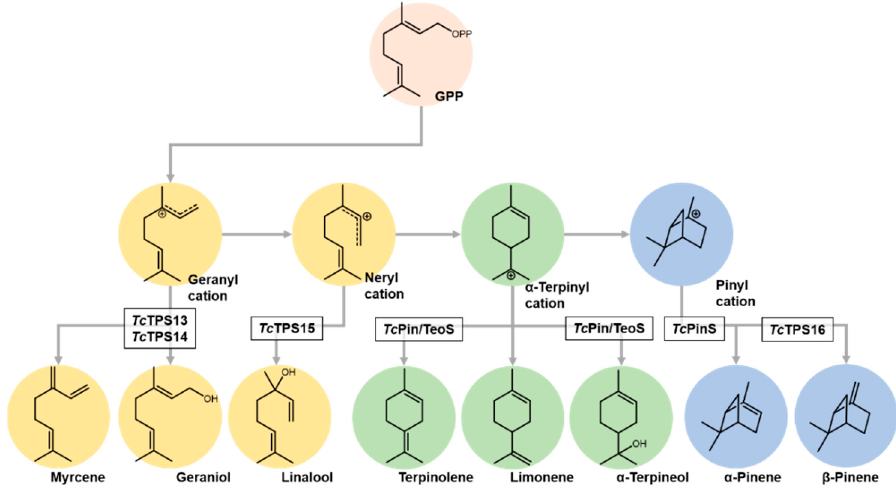
Figure 6. Functionally characterized monoterpene biosynthetic pathway.